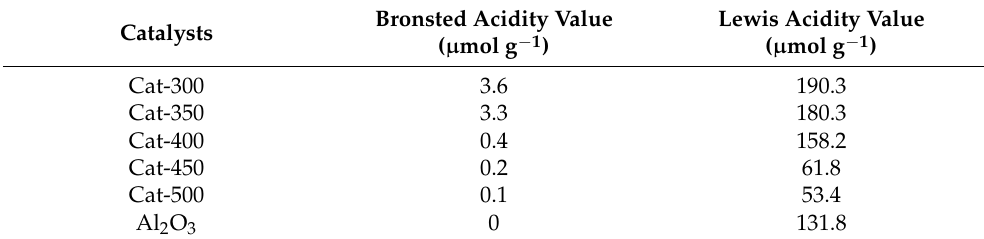
Table 2. Acidity values of different Ni 2 P/Al 2 O 3 catalysts.